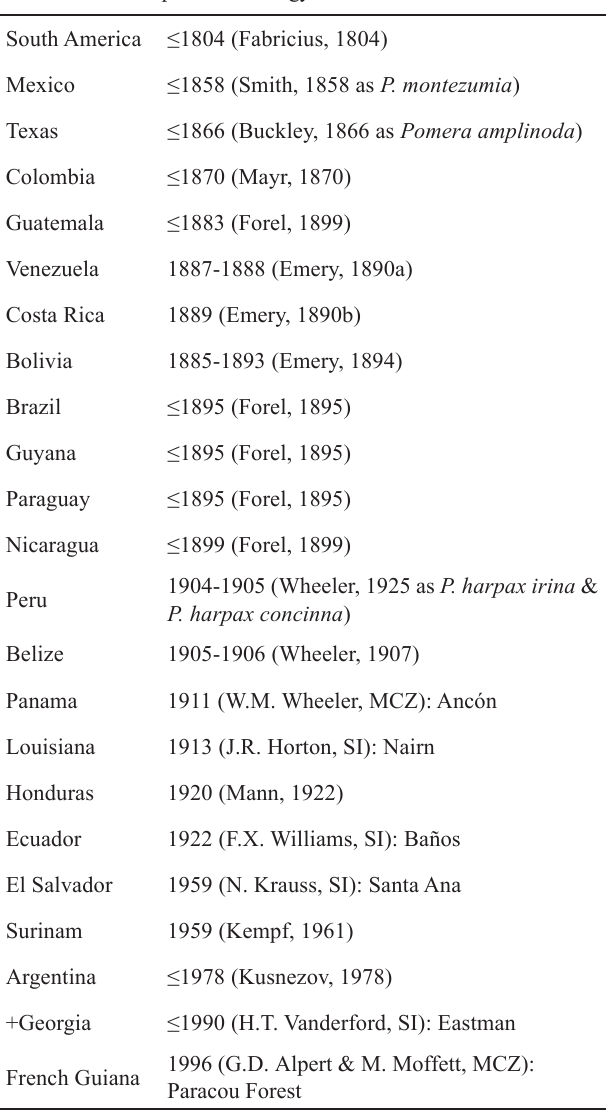
Table 1 . Earliest known records for Pachycondyla harpax in South, Central, and North America. + = no previously published records. MCZ = Museum of Comparative Zoology. SI = Smithsonian Institution.